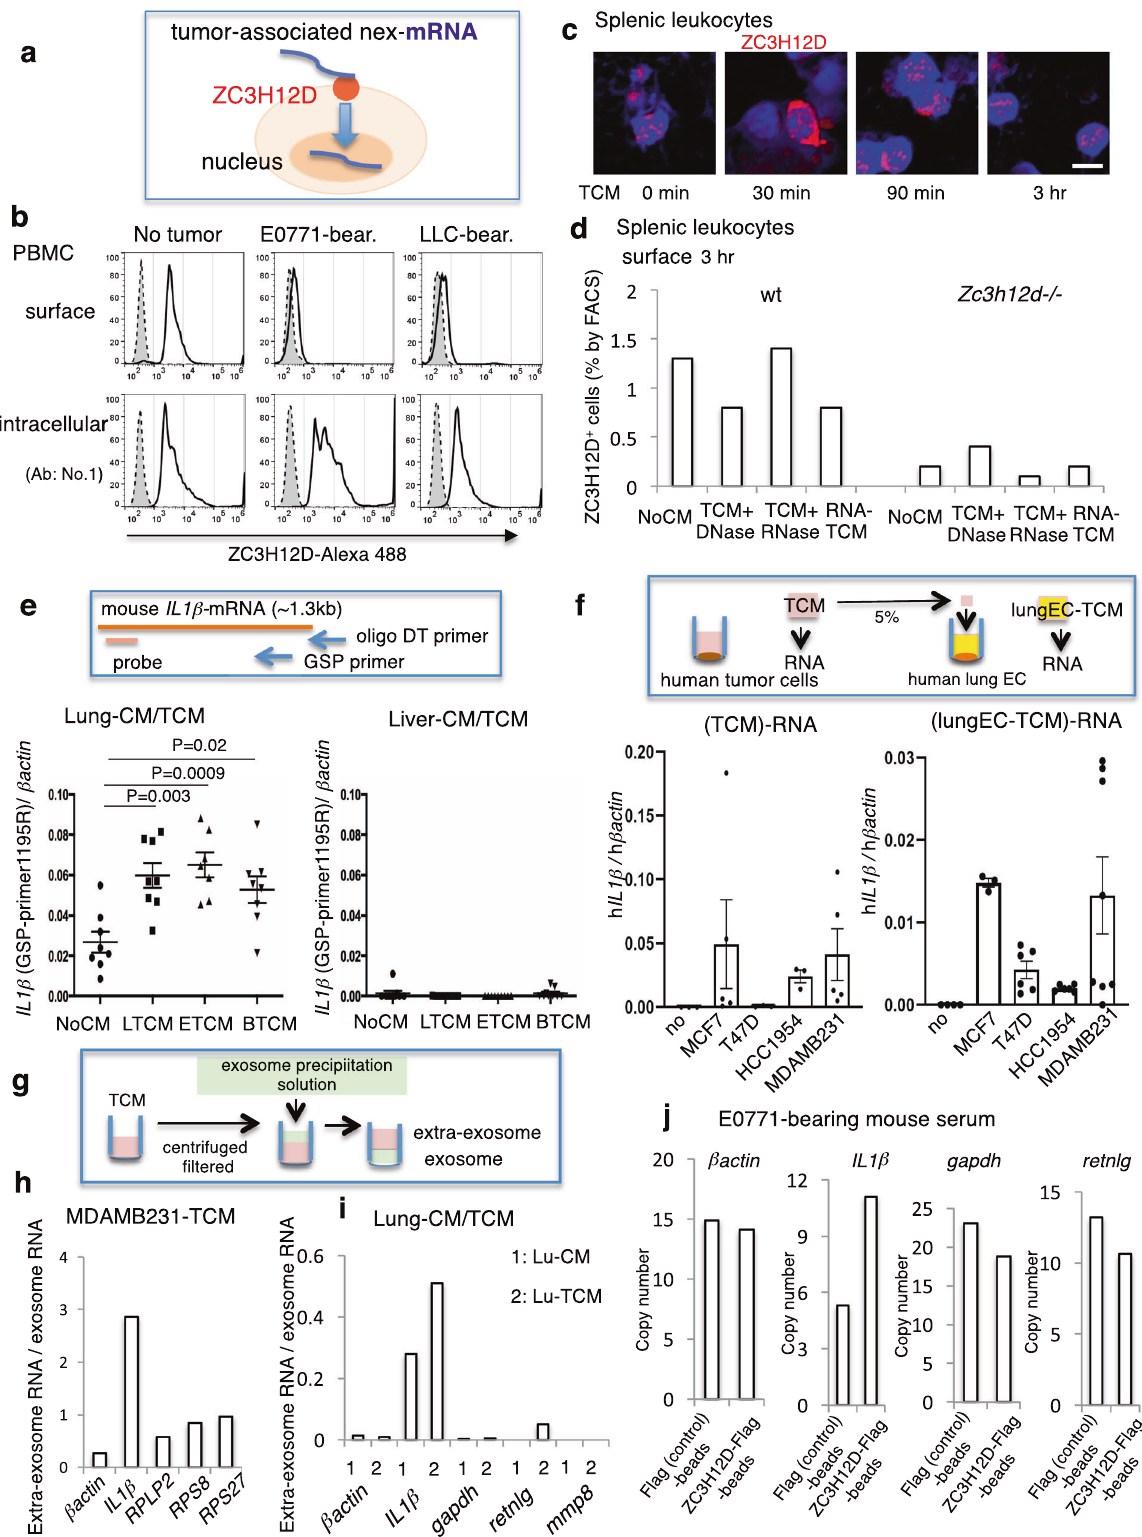
IL1 β - mRNA, CMs were collected from human breast cancer cells, including MCF7, MDAMB231, T47D, and HCC1954 (Fig. 1f, left). Along with these samples, h IL1 β - mRNA was also analyzed in CM from human lung ECs stimulated by the aforementioned TCMs (Fig. 1f, right) because mouse lung culture medium sti- mulated with TCM contained mouse (m) IL1 β - mRNA (Fig.